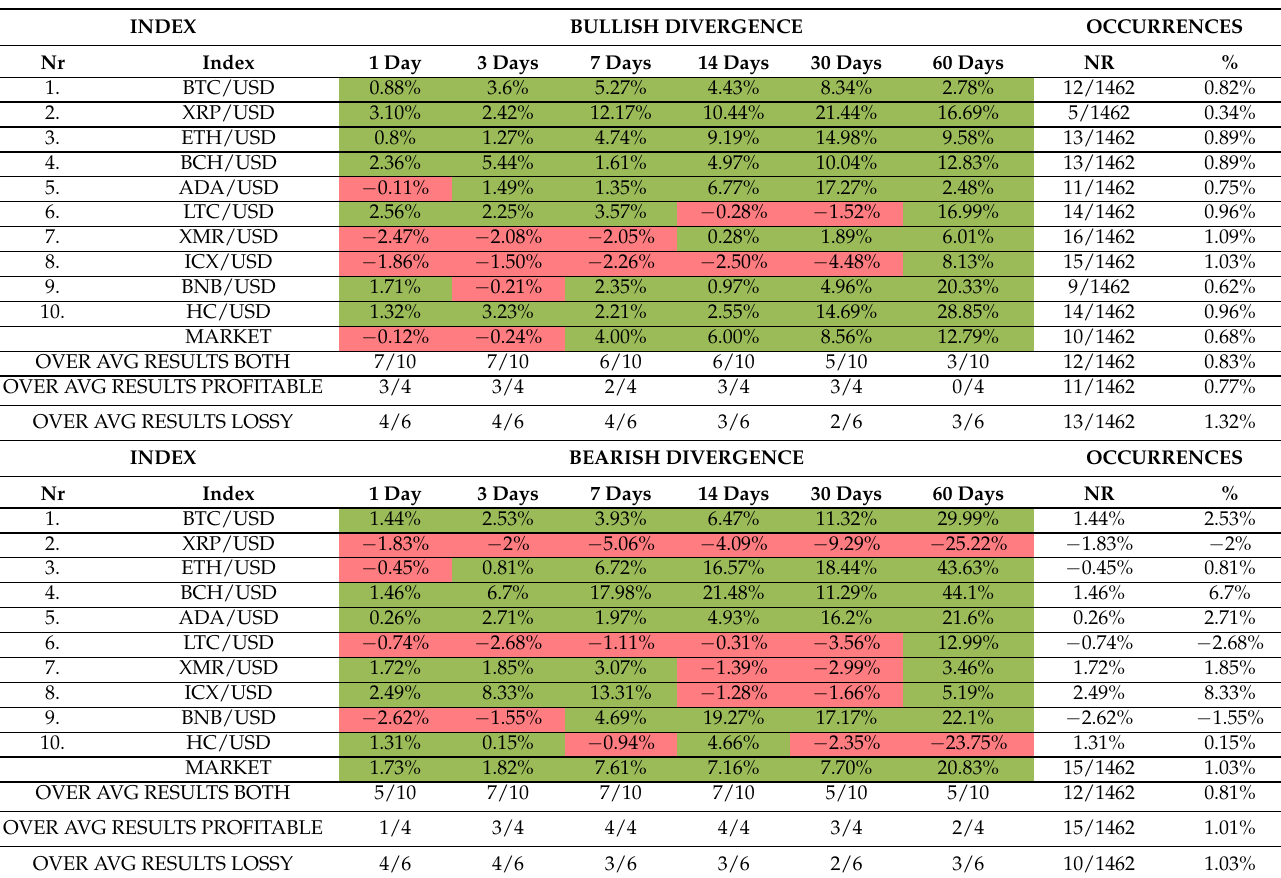
Table 4. Average returns of the examined cryptocurrencies after a selected number of days after the signal generated by the RSI application from the second experiment. In summary, the numbers indicate the number of indexes from a specific group that achieves above-average returns. Green indicates positive results, red indicates negative results.